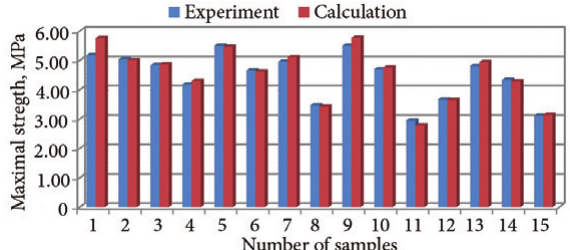
Fig. 3. Results of experimental and calculated definition data comparison R c